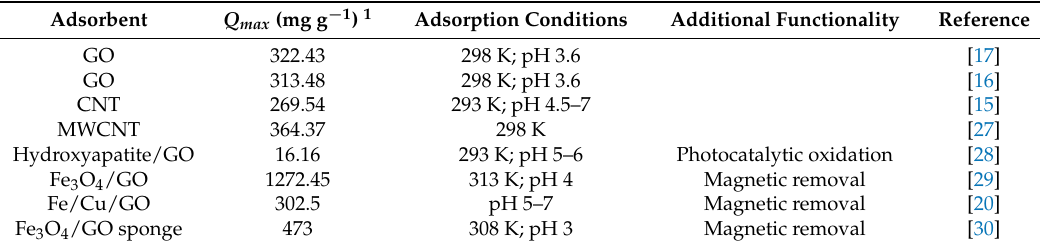
Table 1. Summary of Tetracycline adsorption on carbon nanomaterials and composites.